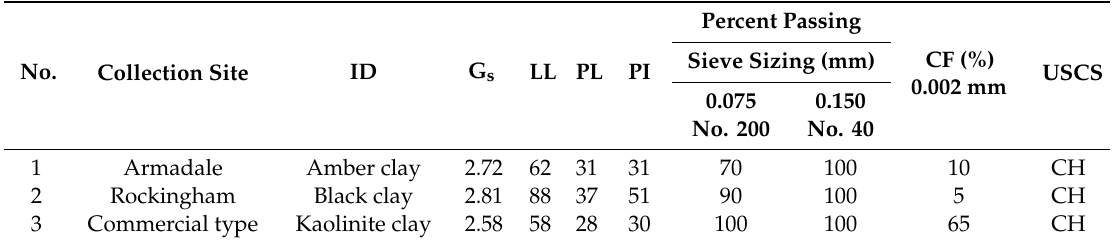
Table 1. Index characteristics of the investigated clays in this